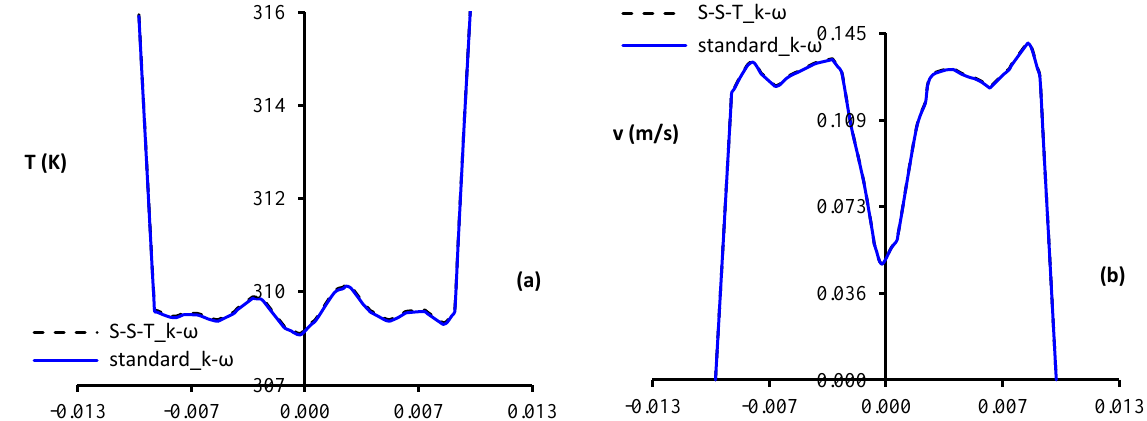
Figure 2. SST 𝛋 − 𝛚 model compared with standard 𝛋 − 𝛚 model for 𝑹𝒆 = 𝟐, 𝟑𝟎𝟎 : (a) temperature, (b) velocity